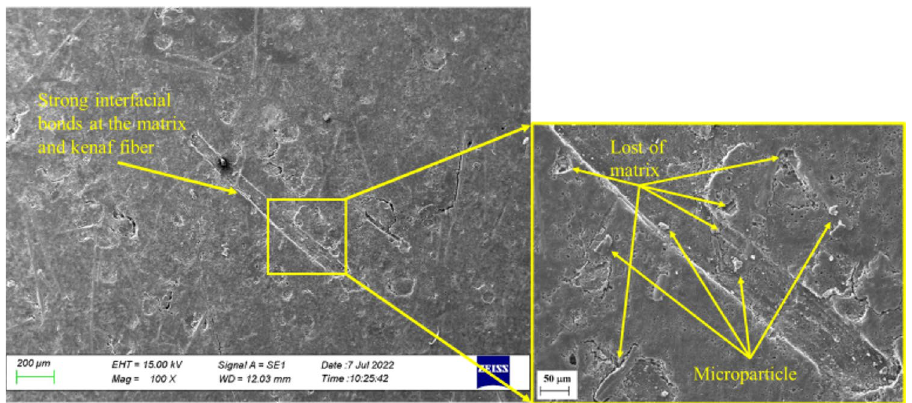
Figure 11. Scanning electron micrographs of the surface of the MCC12 composite post-immersion in distilled water.